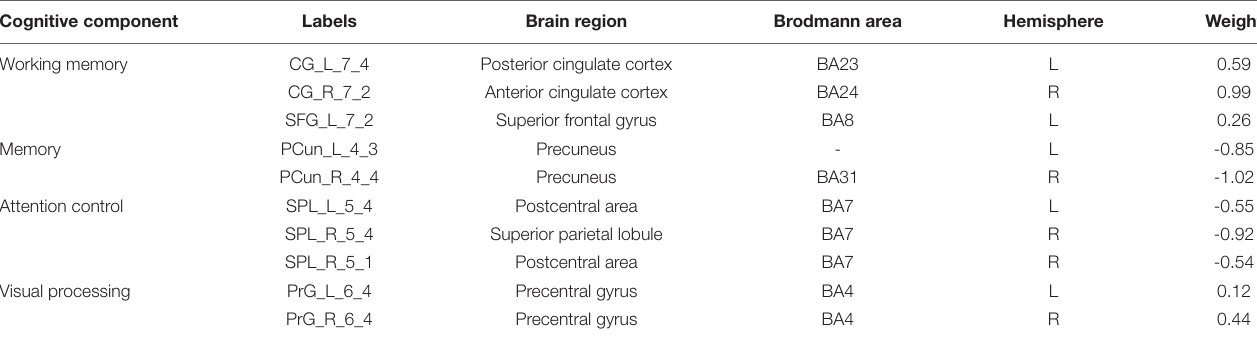
FIGURE 4 | Brain regions with highest discriminative power pre- and post-training. The color bar indicates the weight of the feature. Note that positive weights refer to higher level of ALFF after training, and negative weights refer to lower level of ALFF after training. CG, cingulate cortex; SFG, superior frontal gyrus; PrG, precentral gyrus; SPL, superior parietal lobule; PCun, precuneus; L, left; R, right. TABLE 2 | Brain regions that show highest discriminative power pre- and post -